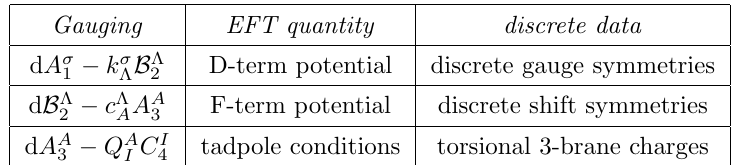
Table 2 . Di(cid:11)erent gaugings in 4d and their related EFT quantities. Their compatibility requires that the constraints k (cid:27)